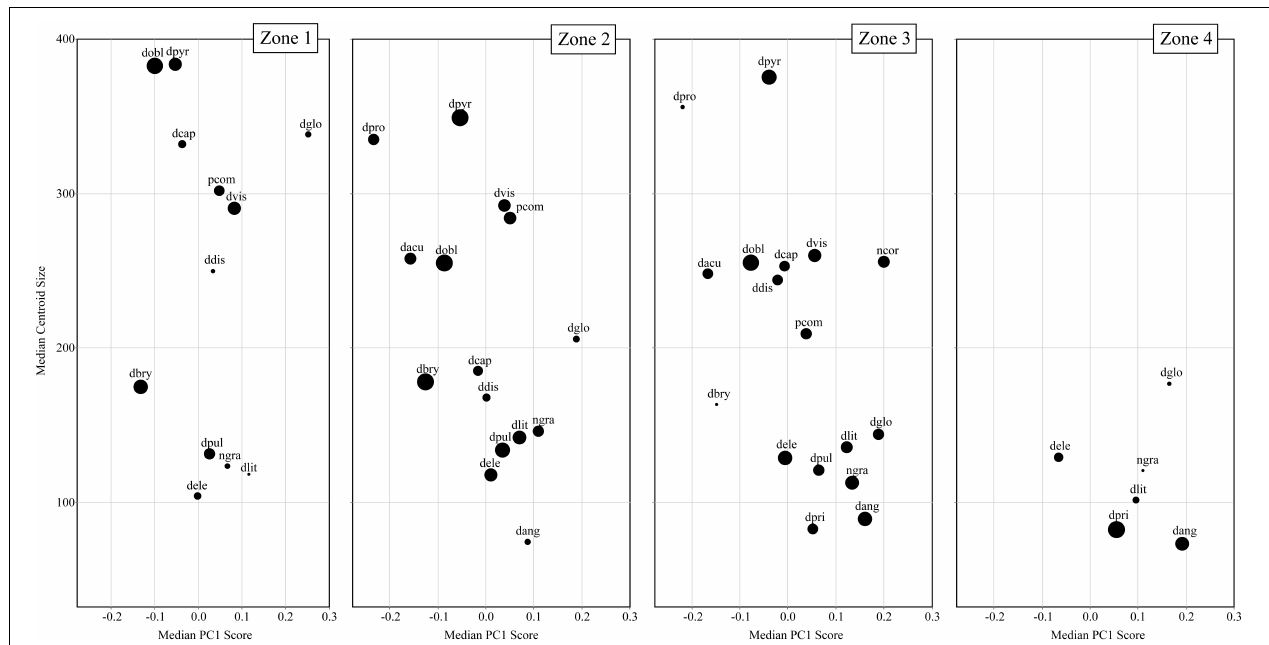
FIGURE 6 | A series of biplots comparing median centroid size to median PC1 scores for each taxa. Each biplot is a different temporal community (i.e., CONISS zones). The size of the dots is relative to species abundance with larger dots reflecting greater relative